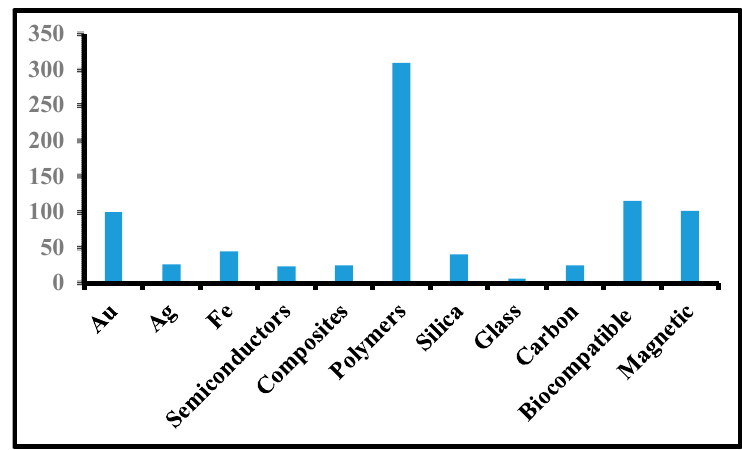
Figure 4. Numbers of the patents on the di ff erent types of NP-based drugs deliver systems.